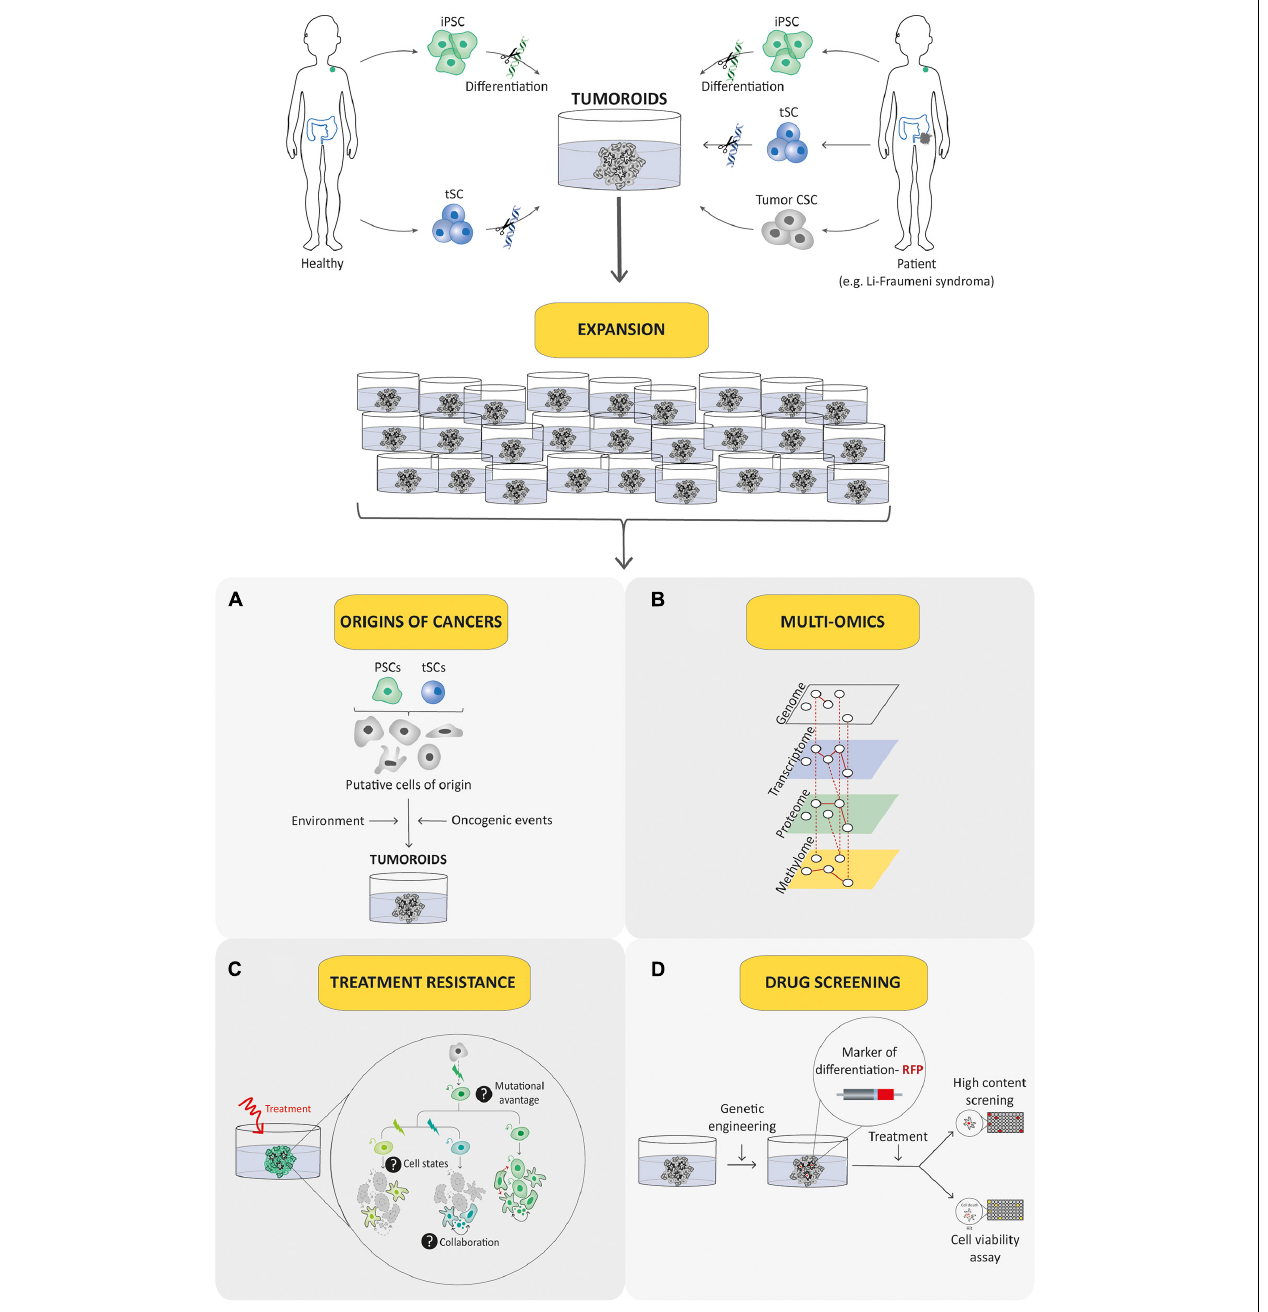
FIGURE 6 | Tumoroid as a promising tool for understanding and treating pediatric cancer. Tumoroid technology can be exploited to model germline pediatric cancer predisposition syndrome, to study origins of cancers (A) and to perform multi-omic profiling analyses (B) in order to promote the understanding of pediatric cancer biology. In addition, tumoroids can be used to identify the biological underpinnings of cell death resistance such as tumoral cells state dynamics and collaboration (C) and to perform drug-screening analyses based notably on phenotypic screens (D) to explore innovative and powerful therapeutic